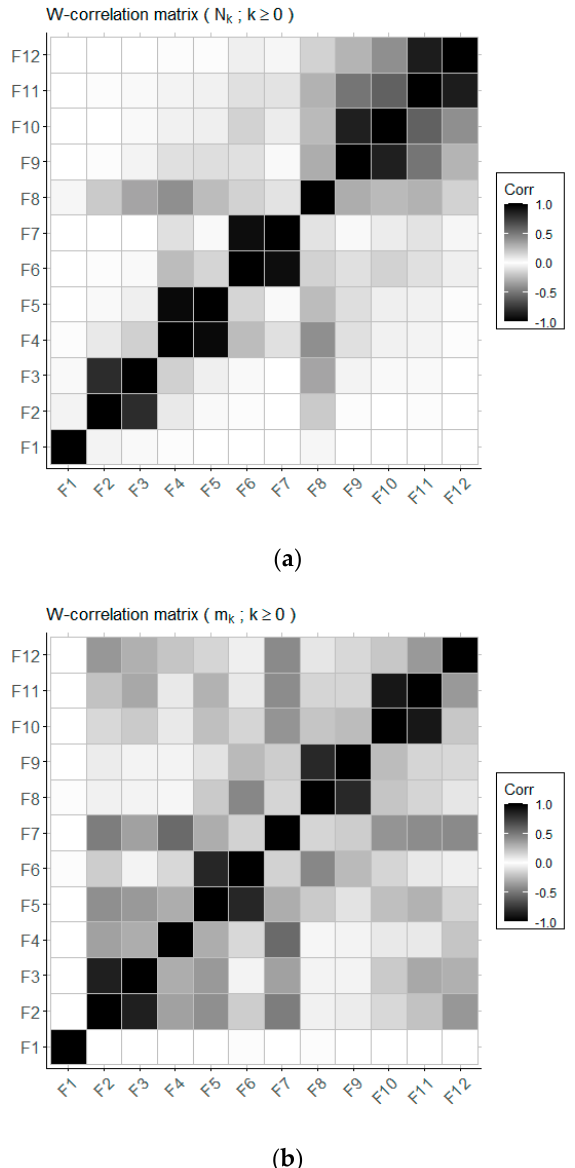
Figure 8. W-correlation matrix plots for the first 12 components of the earthquake number series ( a ) and the annual maximum magnitude series ( b ).